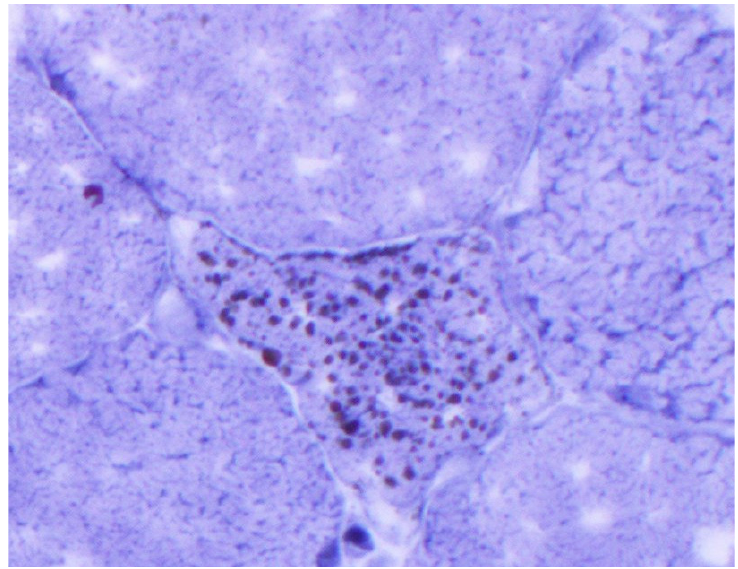
Figure 4. Sudan black stain: lipid droplets in scattered and intact myofiber (high power).